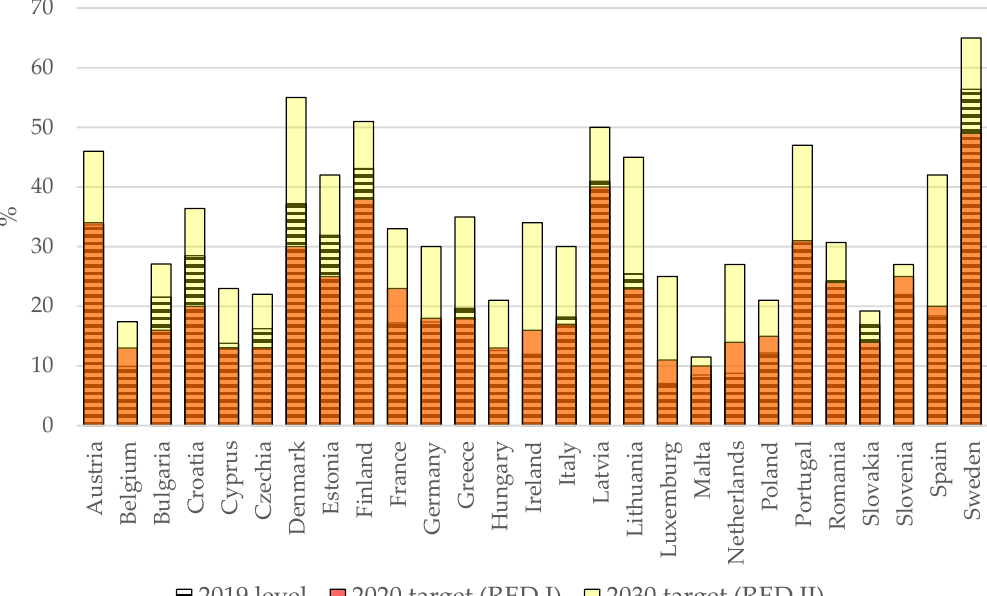
Figure 1. Actual (2019) and targeted (RED I by 2020 and RED II by 2030) shares of renewable energy in gross final energy consumption in the EU-27 countries. Source: own compilation based on [10,12,13].